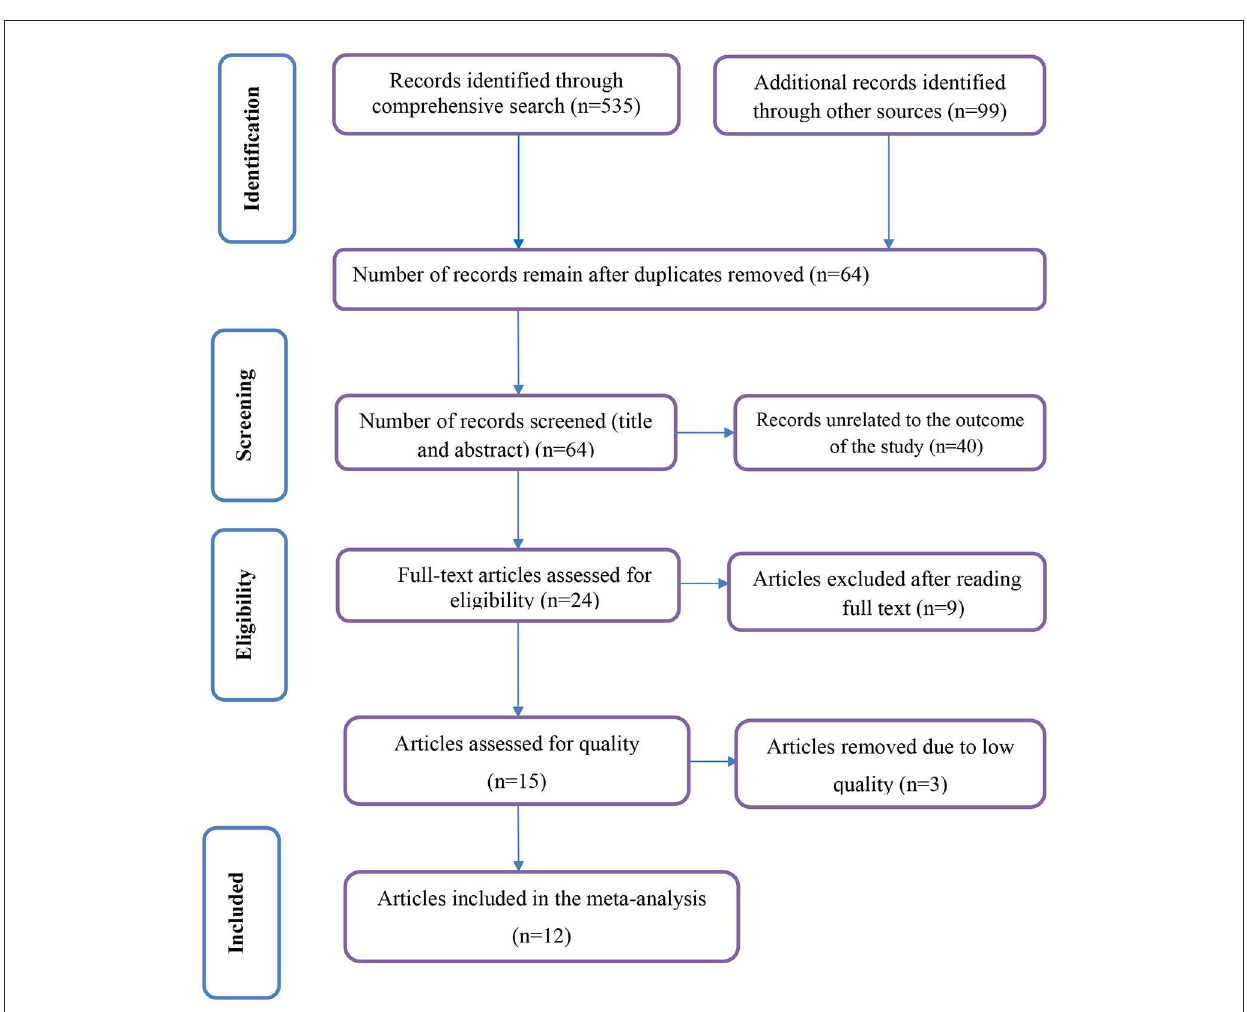
FIGURE1 PRISMA flow diagram of included studies in the systematic review and